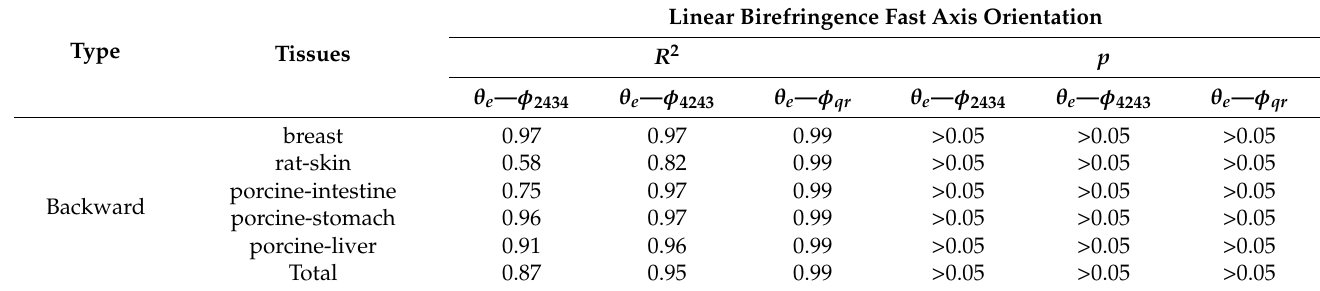
Table 7. Correlation and statistical analysis comparison results between backward measured MMT and MMPD linear birefringence orientation parameters for each kind of bulk tissue